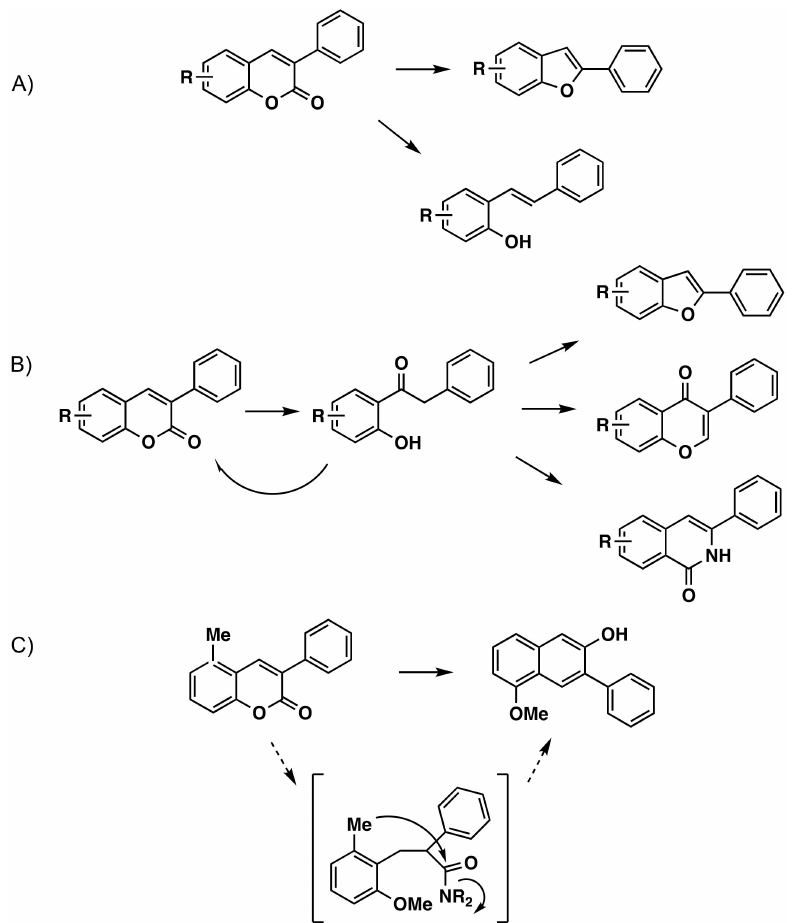
Figure 10. Three different reactions for the synthesis of new molecules with modifications of the 3-arylcoumarin scaffold. ( A ) Synthesis of a variety of 2-arylbenzofurans from 3-arylcoumarins, through a copper-catalyzed decarboxylative intramolecular CO coupling one-pot reaction. Synthesis of o -hydroxystilbenes from 3-arylcoumarins via hydrolysis/decarboxylation cascade reaction in the presence of KOH. ( B ) Simple, green and efficient approach to obtain 2-hydroxydeoxybenzoins, from the microwave-assisted alkali degradation of 3-aryl-4-hydroxycoumarins in water. ( C ) Synthesis of aryl-2-naphthols via a general and efficient one-pot methodology using highly substituted 2-naphthols, exploring the dual nature of lithium